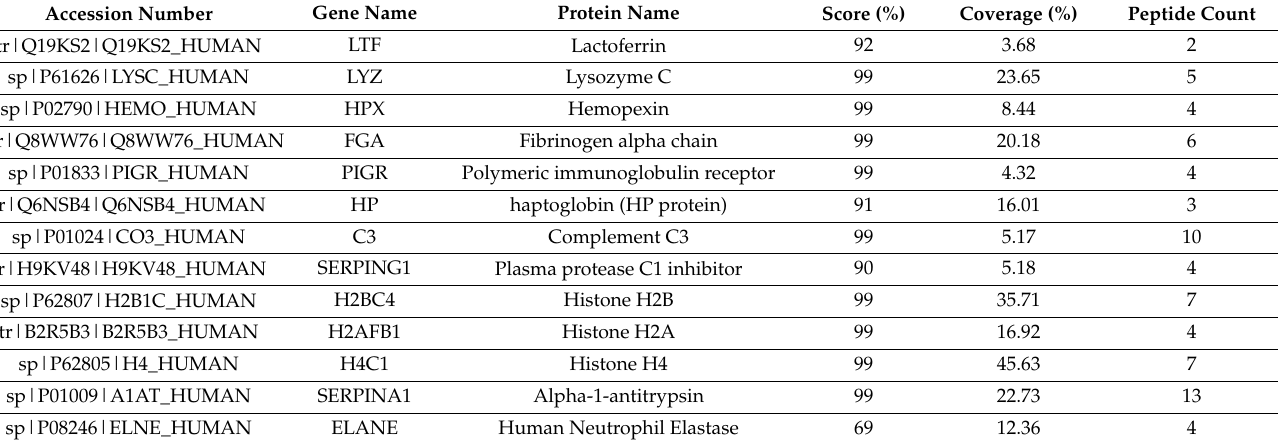
Figure 3. 12.5% SDS-PAGE (on the left) showing the protein profile of the BALf samples considered. The gel on the right shows an expansion (obtained by running the samples on an 8% gel) of the region marked with a dotted line in the gel on the left. The bands excised, digested with Trypsin, and submitted to protein identification by LC-MS are those indicated by the letters A to G in both gels. Table 3. Most significant proteins identified by LC-MS/MS under the bands excised from the gels.